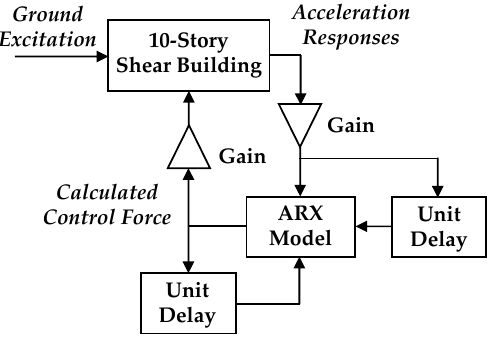
Figure 10. Control simulation model of the ARX (autoregressive with exogenous inputs).